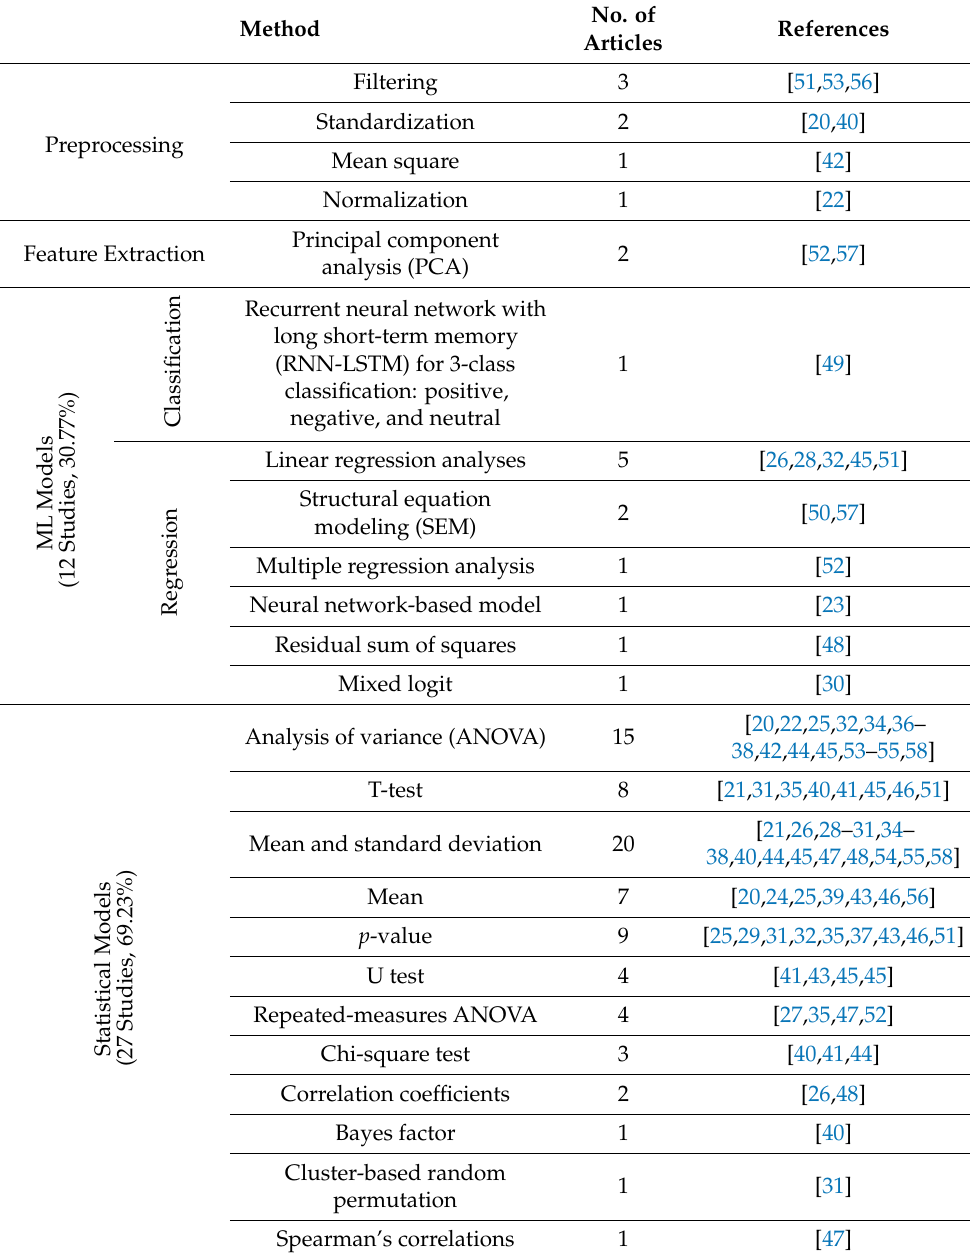
Table 5. Computation methods in neuro-tourism